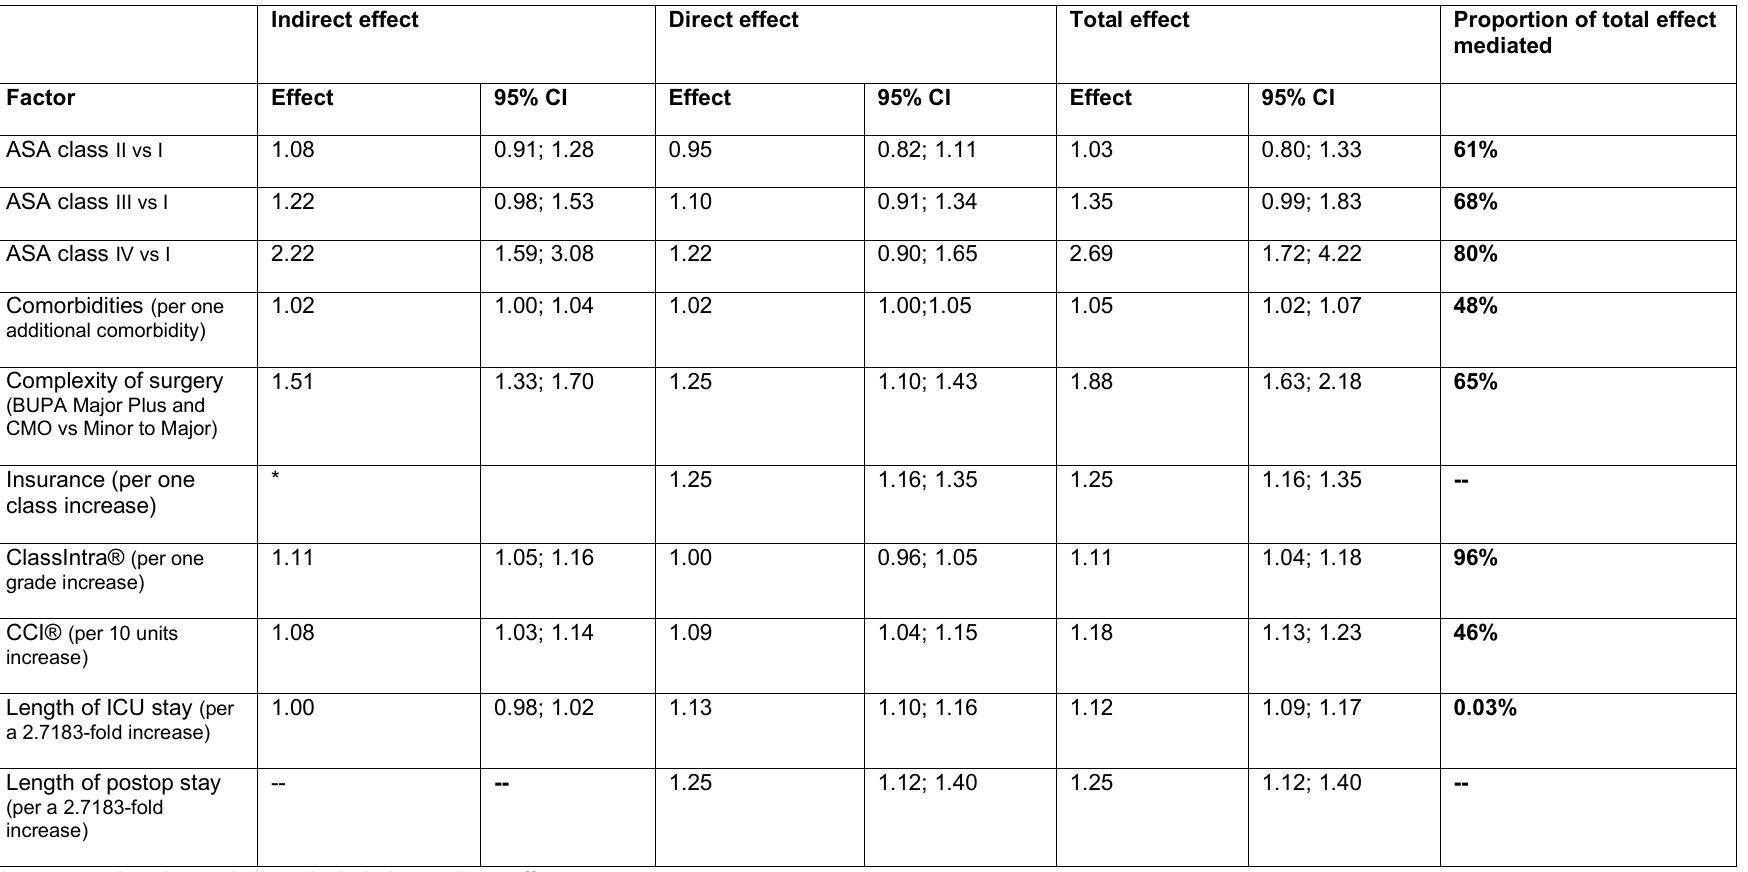
Table 6: Log-cost model excluding recurrent patients Indirect, direct and total effects on log-cost. Coefficients are exponentiated to report the ratio in geometric means associated with a one-unit increase in the corresponding predictor variable. From these ratios, the percentage increase in geometric mean can be derived using the formula 100*(effect-1), e.g. 1.08 corresponds to an 8% increase in geometric mean among ASA II as compared to ASA I patients);